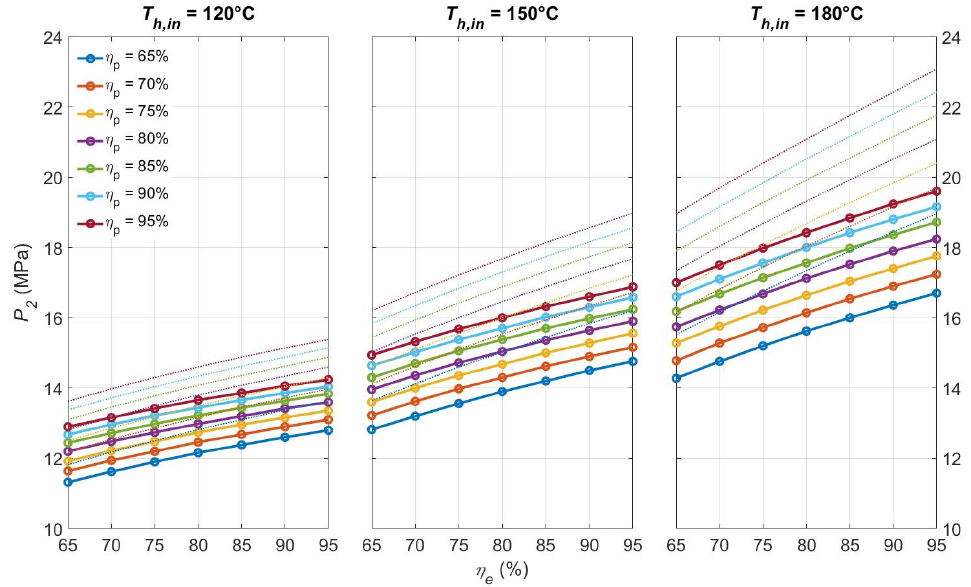
Figure 13. P 2 of the recuperative cycle at the design point under different circumstances of η p , η e , and T h , in (the dotted lines represent the value of simple cycle in Figure 8).